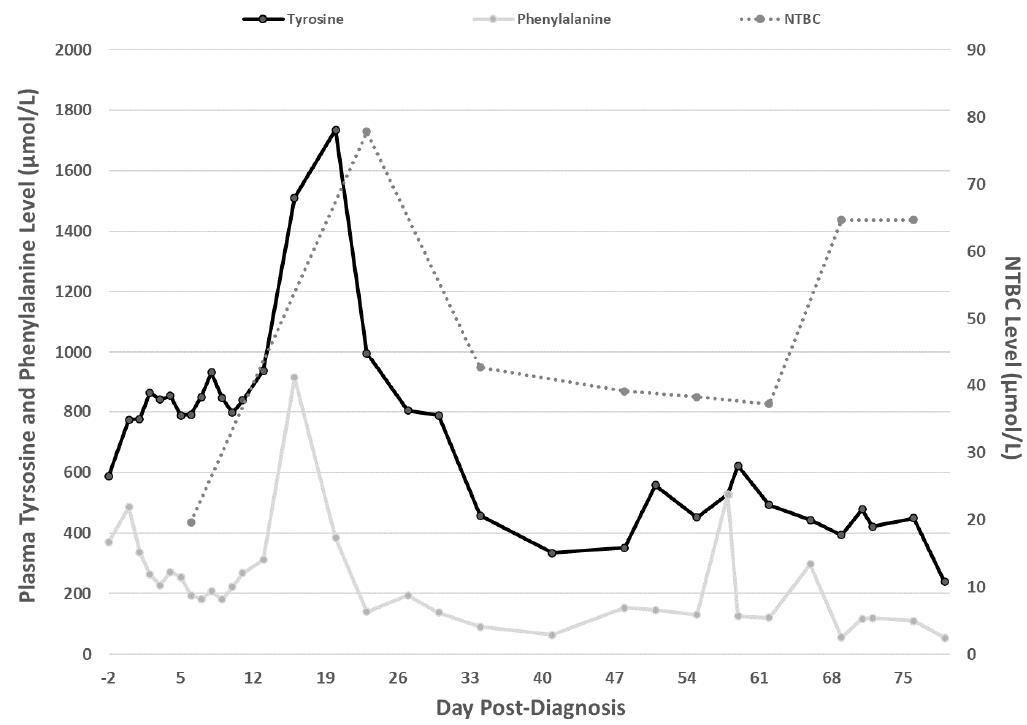
Figure 1. Patient tyrosine, phenylalanine, and 4-hydroxyphenylpyruvate dioxygenase inhibitor 2-(2-nitro-4-trifluoromethylbenzoyl)-1, 3-cyclohexanedione (NTBC) plasma levels over time. Normal tyrosine ranges between 22–102 µmol/L and normal phenylalanine ranges between 23–95 µmol/L. NTBC therapy was initiated on the first day following diagnosis using weight ‐ based dosing. NTBC levels were quantified at Seattle Children’s Hospital Laboratory and are shown on the right y ‐ axis. The NTBC therapeutic window is 40–60 µmol/L.